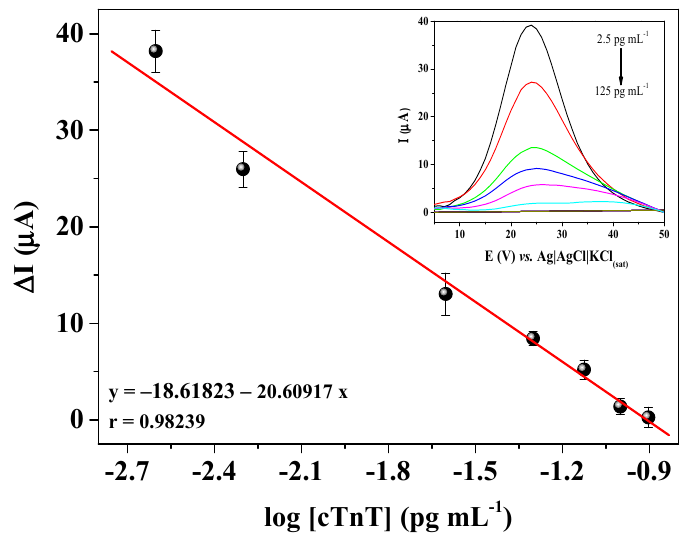
Figure 6. Calibration curve of the immunosensor for different cTnT concentrations (2.5, 5, 25, 50, 75, 100 and 125 pg mL − 1 ) by SWV measurements performed in 5 mmol L − 1 [Fe(CN) 6 ] 3 − /4 − solution prepared in 0.1 mol L − 1 KCl.